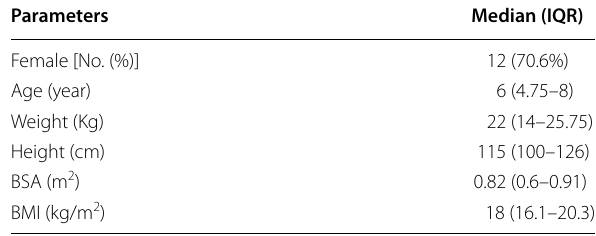
Table 1 Demographic characteristics of the